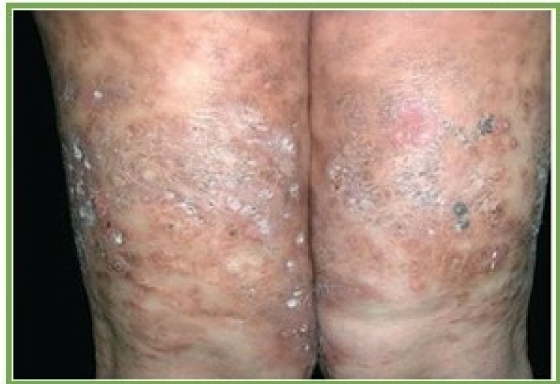
Figure 6. Cutaneous nodules and plaques. With permission from Pattanaprichakul, P., et al. Disseminated gouty panniculitis: an unusual presentation of extensive cutaneous tophi.